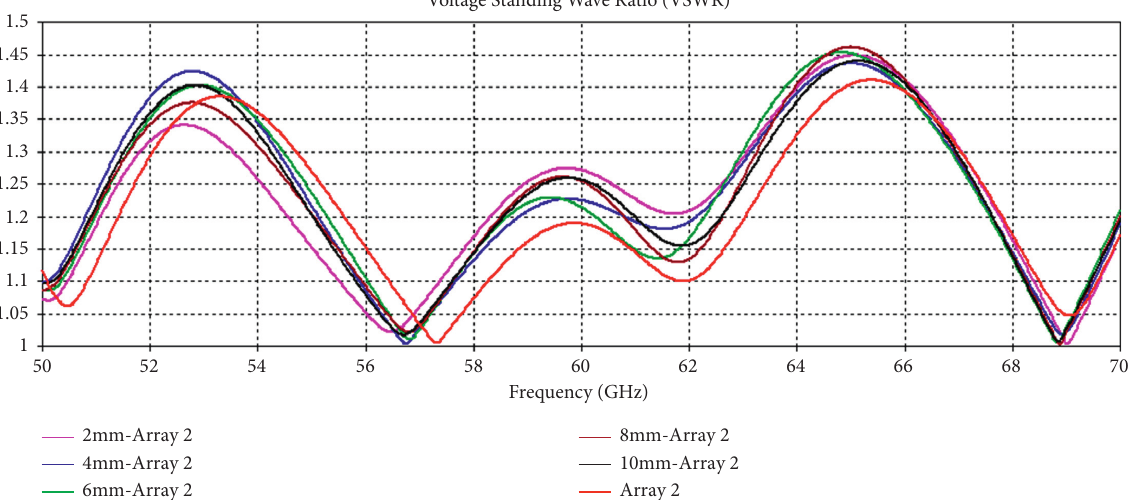
Figure 22: Array 2 on-body VSWR at different distances compared to free space.